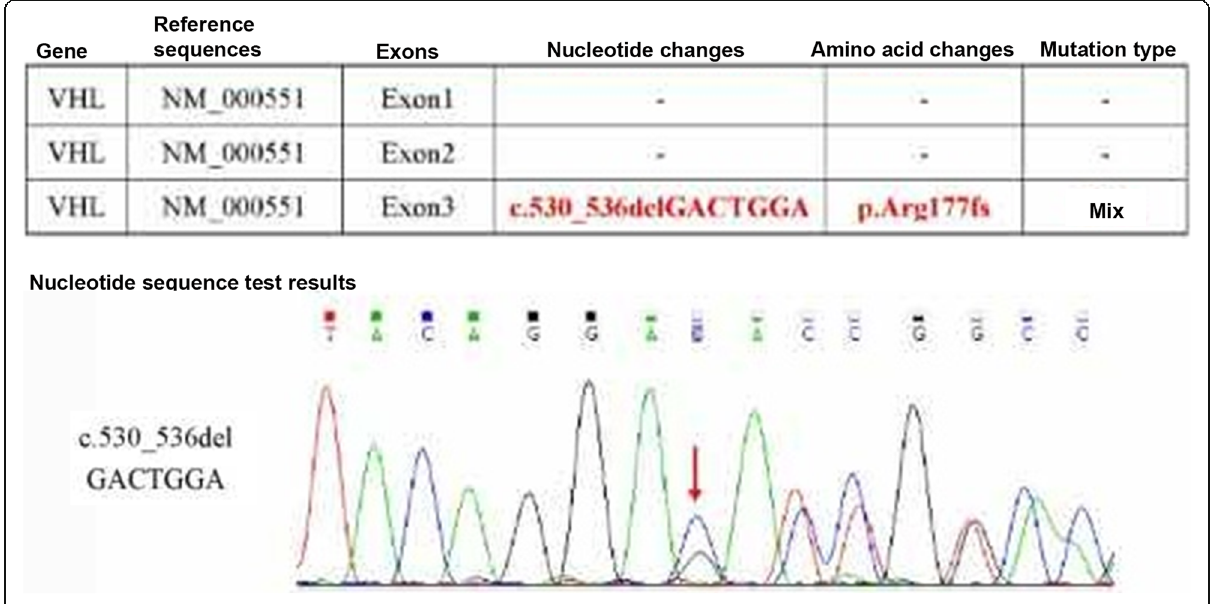
Fig. 6 VHL gene testing results of case 2. The GACTGGA sequence was deleted in the VHL gene in case 2 by using extracted DNA from patient blood. This deletion resulted in the alteration of Arg-177 in the VHL